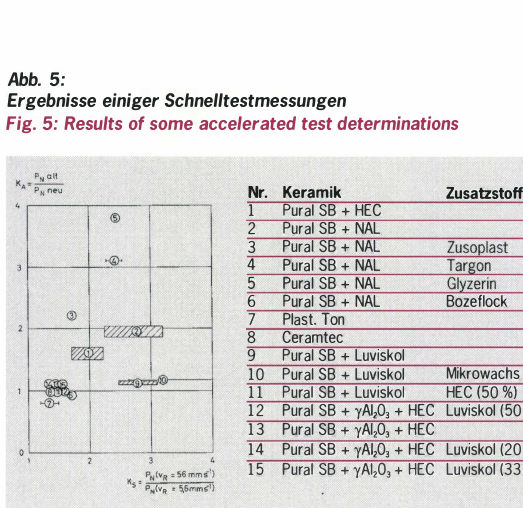
Fig. 5: Results of some accelerated test